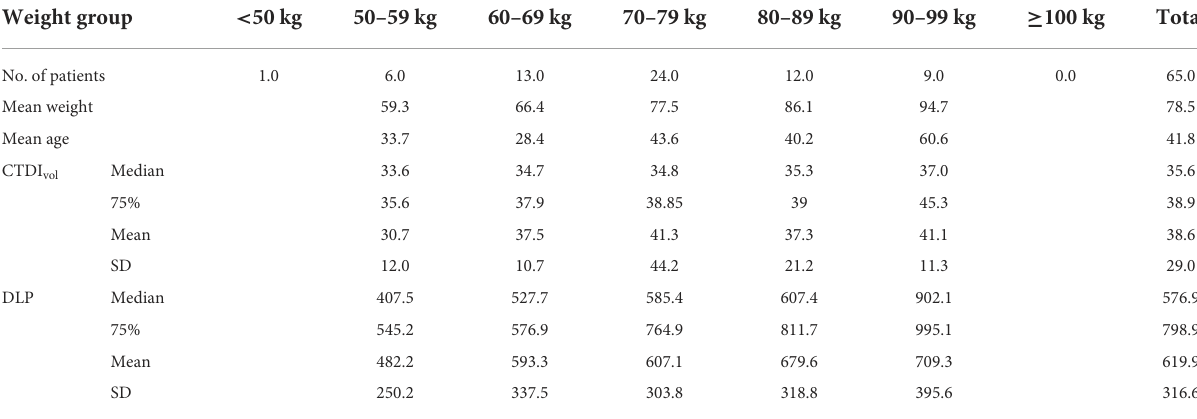
TABLE 3 Distribution of head CT with CM for patients in different weight